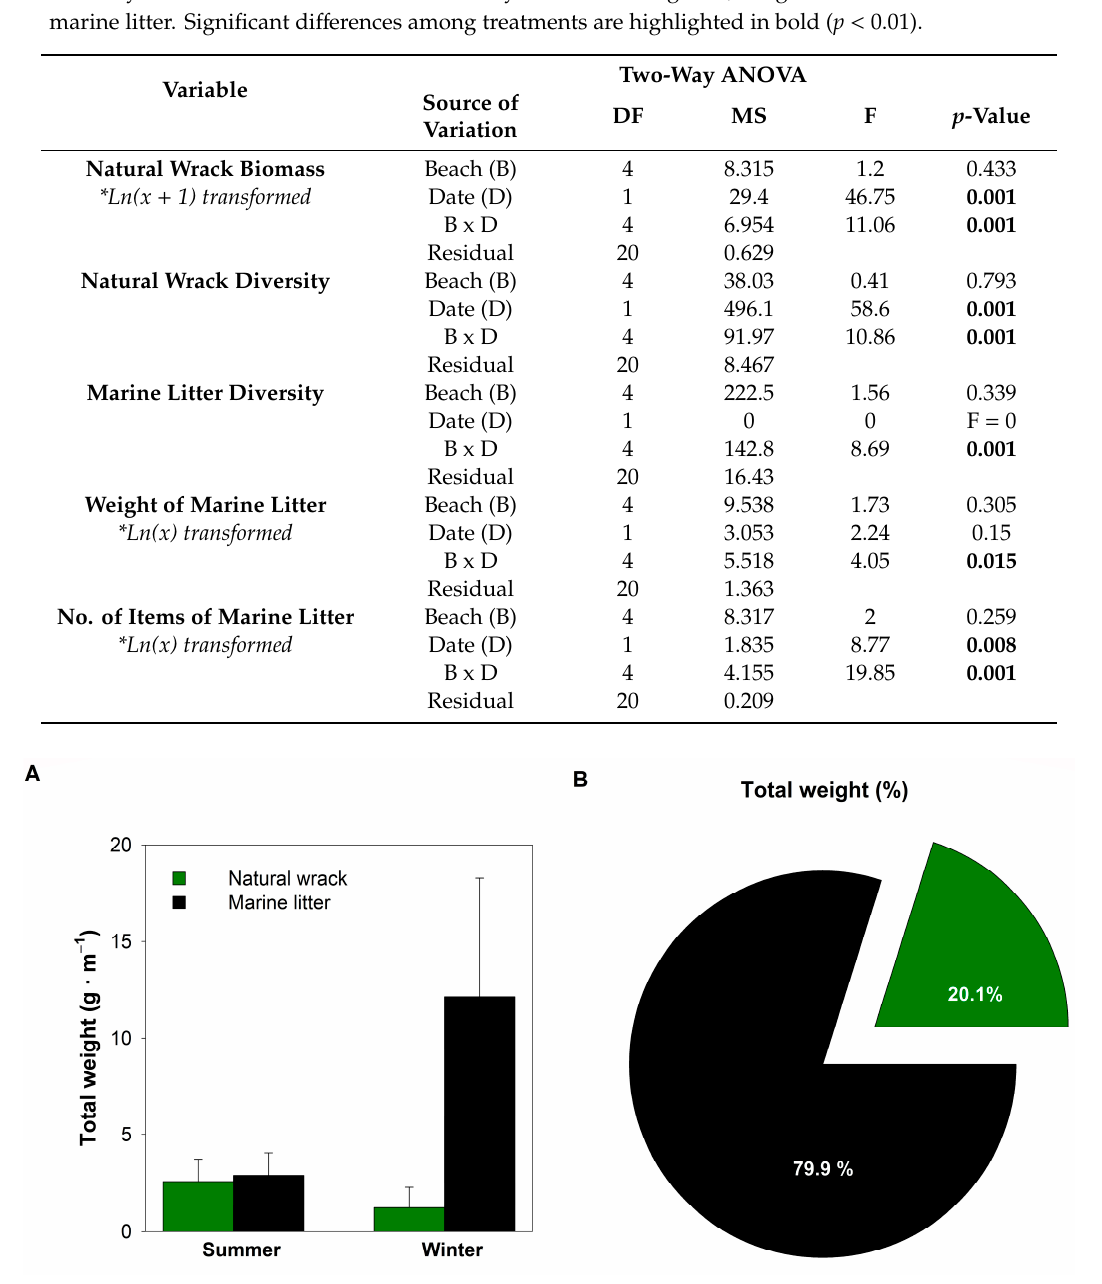
Figure 2. Average of the total weight of natural wrack and marine litter per date ( A ) (mean ± SE; n = 5) and percentage of natural wrack (green) and marine litter (black) with respect to the overall weight of both accumulations over the study period ( B